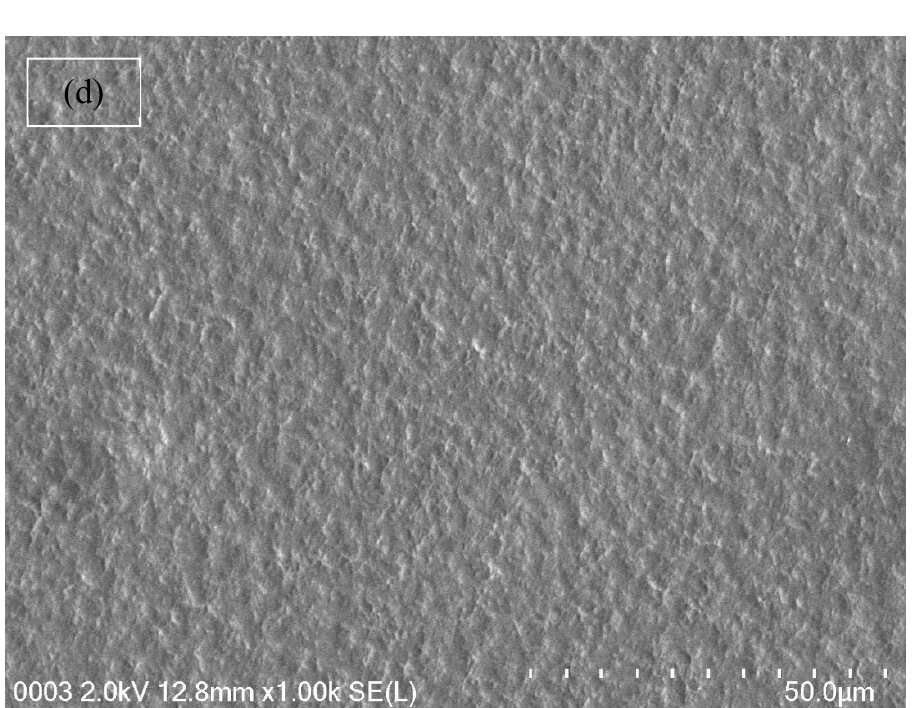
Figure 5. Field emission scanning electron microscopy (FESEM) images for ( a ) CSDX 1, ( b ) CSDX 2, ( c ) CSDX 3, and ( d ) CSDX 4 blend electrolytes.